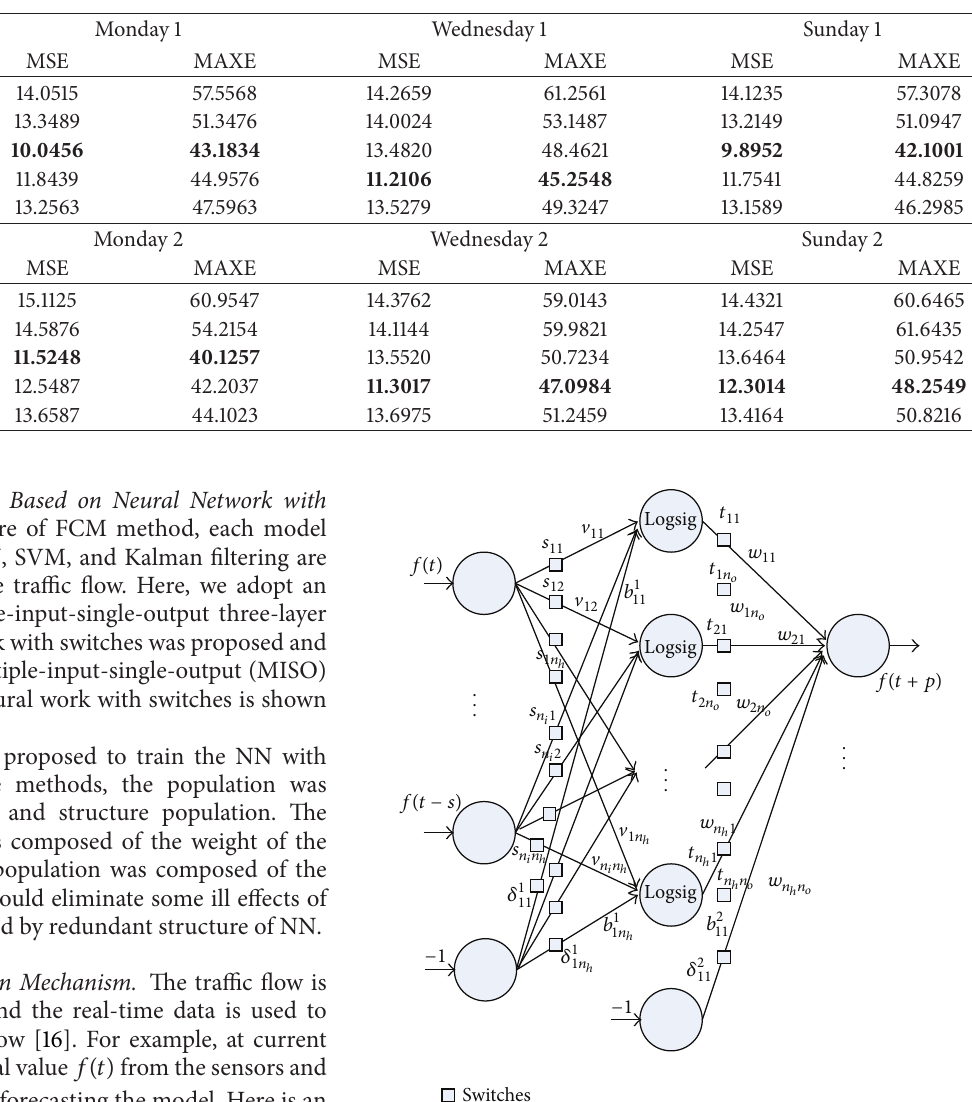
Table 1: The result of the FCM.